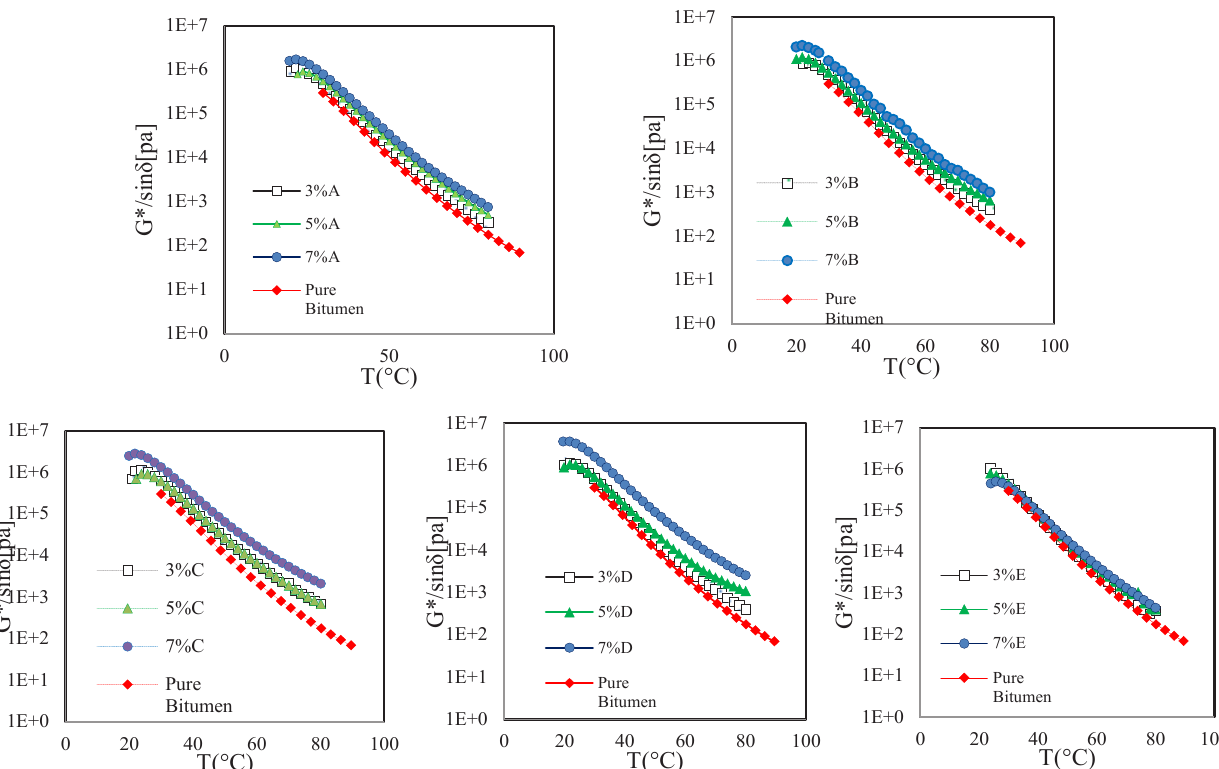
Fig. 9. Rutting resistance for the pure bitumen and the ones modified by blend A (top row, left), blend B (top row, right), blend C (down row, left), blend D (down row, middle) and blend E (down row, right) at different temperatures.